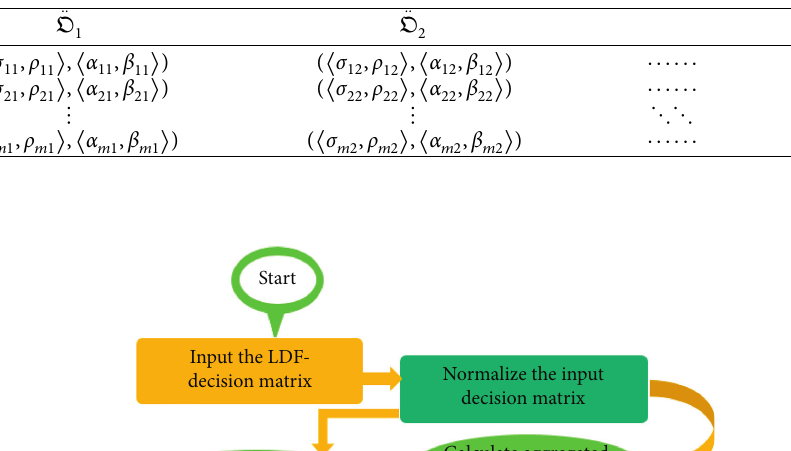
Table 5: The judgement matrix in terms of LDFNs.